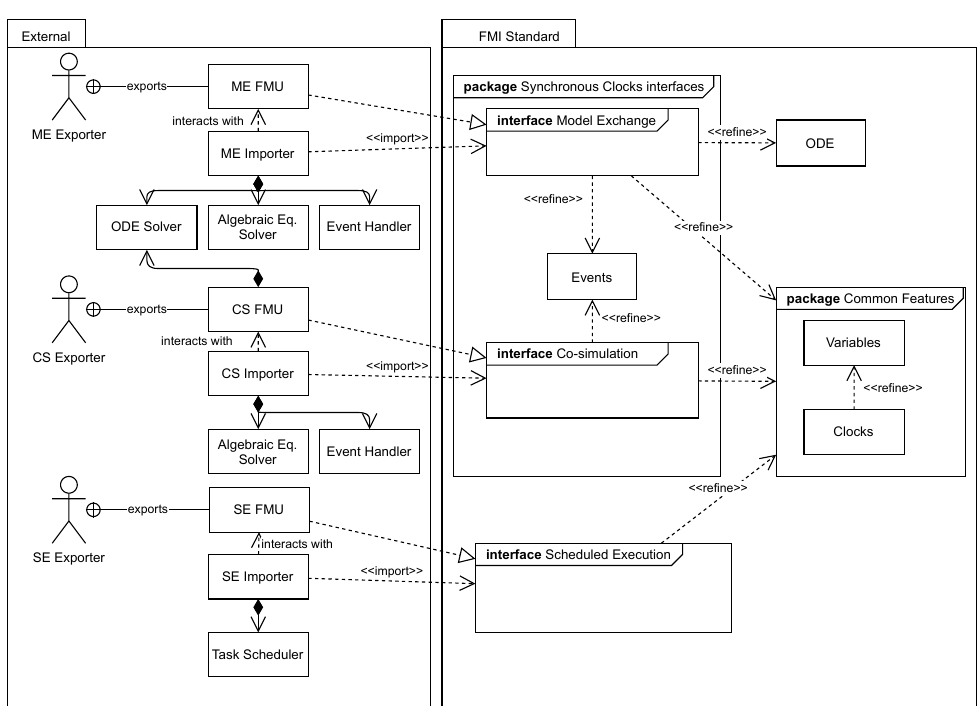
Figure 1. Overview of relevant concepts. Please note that there might be domain-specific importers which do not need an ODE solver because the supported FMUs do not contain continuous variables. This figure attempts to illustrate the most common differences between the interface